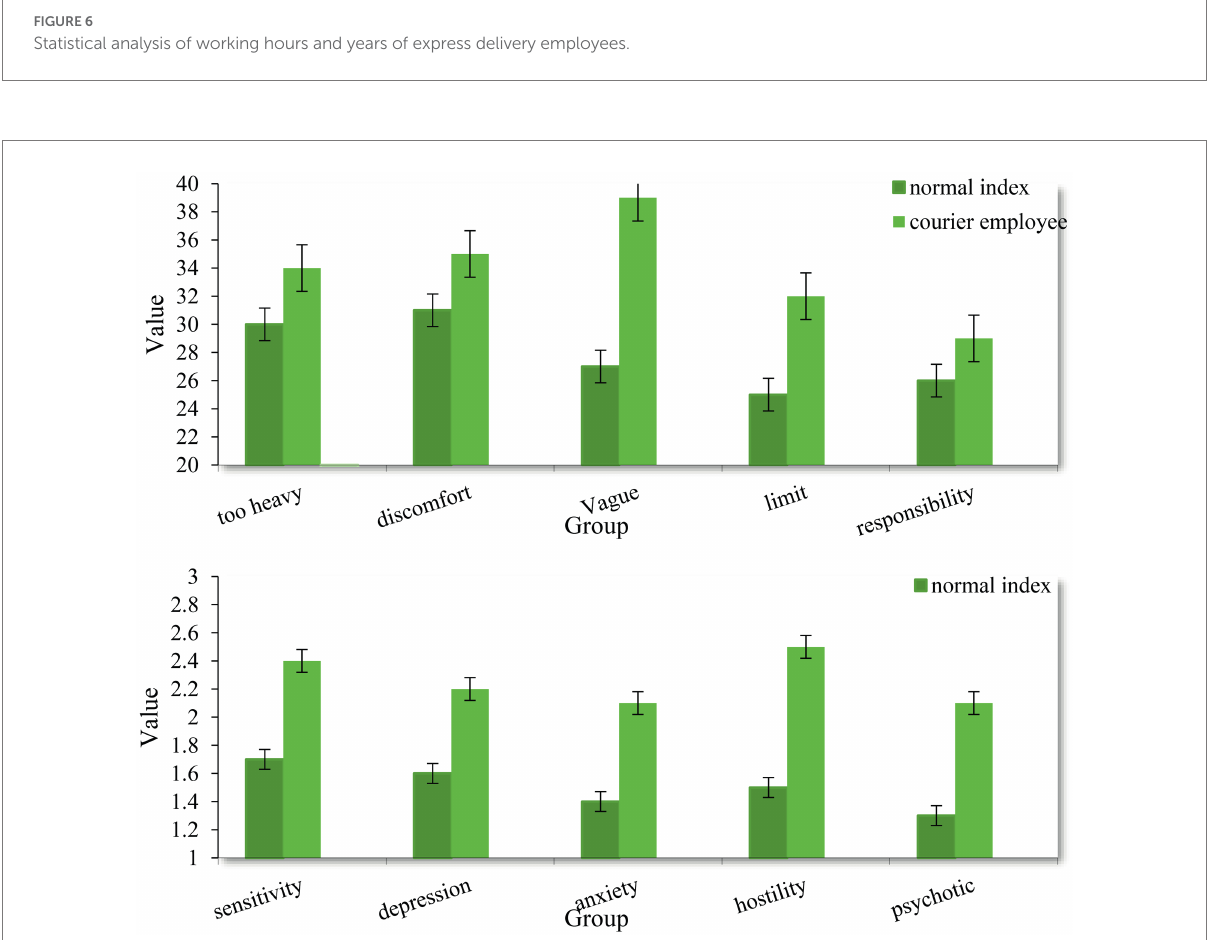
FIGURE 7 Analysis of occupational stress and mental health level of express delivery